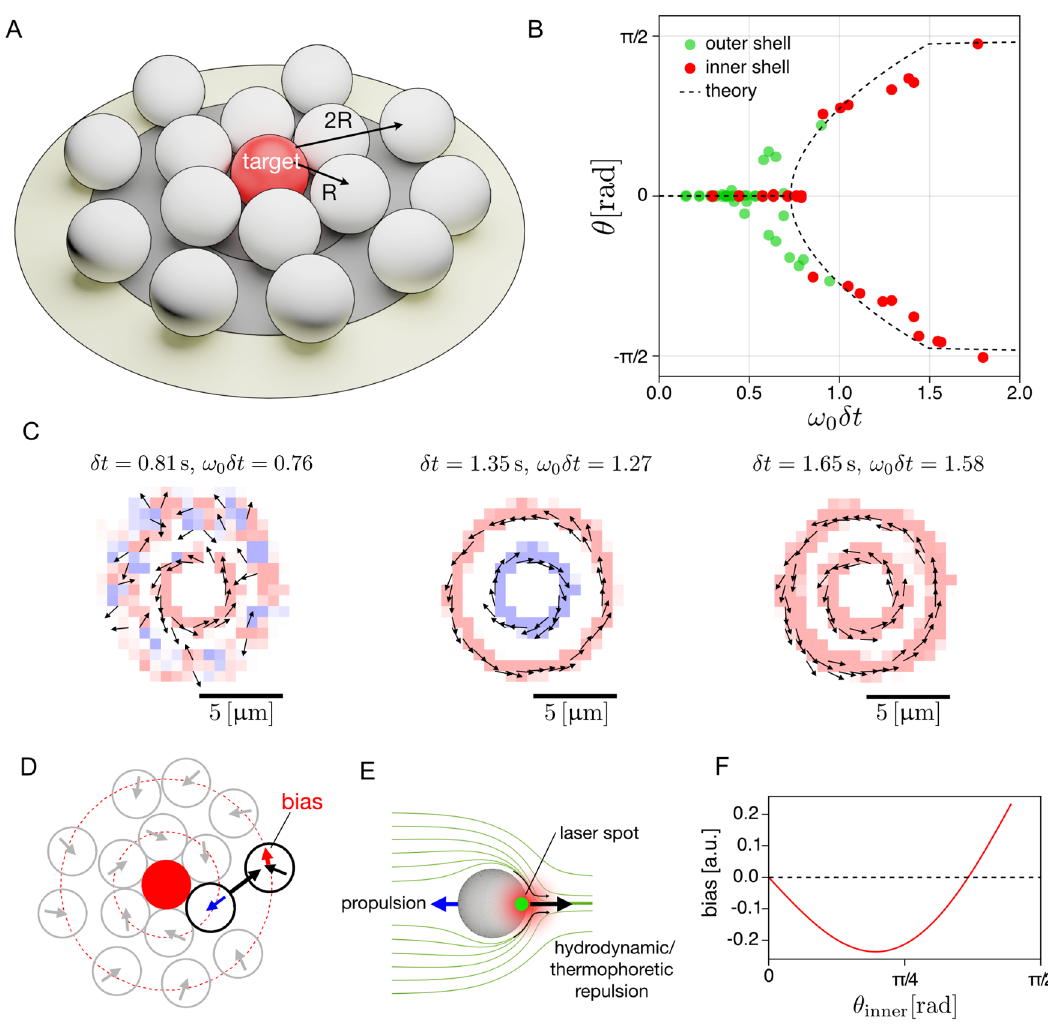
Fig. 4 | Collective rotation of 15 particles attracted to a single target particle. A Sketch of the shell structure and radii. B Bifurcation of the most probable propulsion angle asa functionofthe controlparameter ω 0 δ t for a(calibrator) propulsion speedof v 0 = 2.06 μ m s − 1 .Thered dotsareobtained from theinner shell particles at a typical distance of R in = 2.18 μ m, while the green dots denotetheoutershellparticlesat R out = 4.47 μ m.Thedashedlinecorresponds to the theoretical single-particle prediction, including the instrumental delay Δ t = 70 ms. C Average velocity fi eld of active particles at δ t = 0.81 s when the spontaneous rotation of the inner shell is constantly disrupted by the non- rotating outer shell, at δ t = 1.35 s when the two shells are counter-rotating,